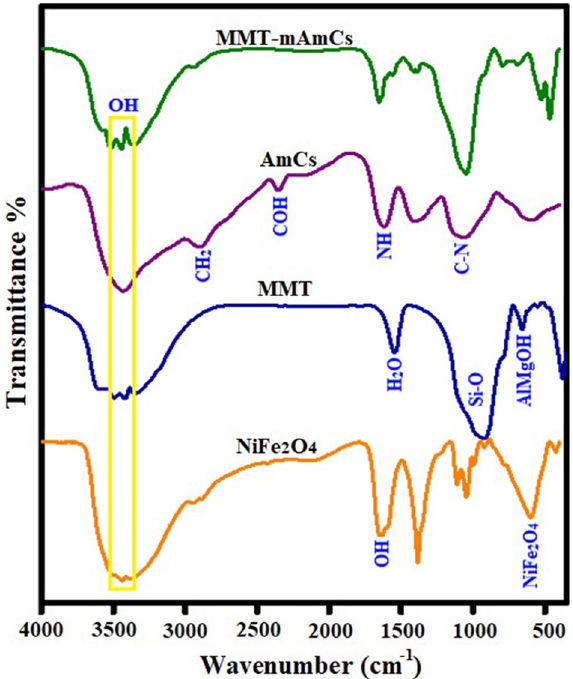
Figure 1. FTIR of NiFe 2 O 4 , MMT, AmCs and MMT-mAmCs